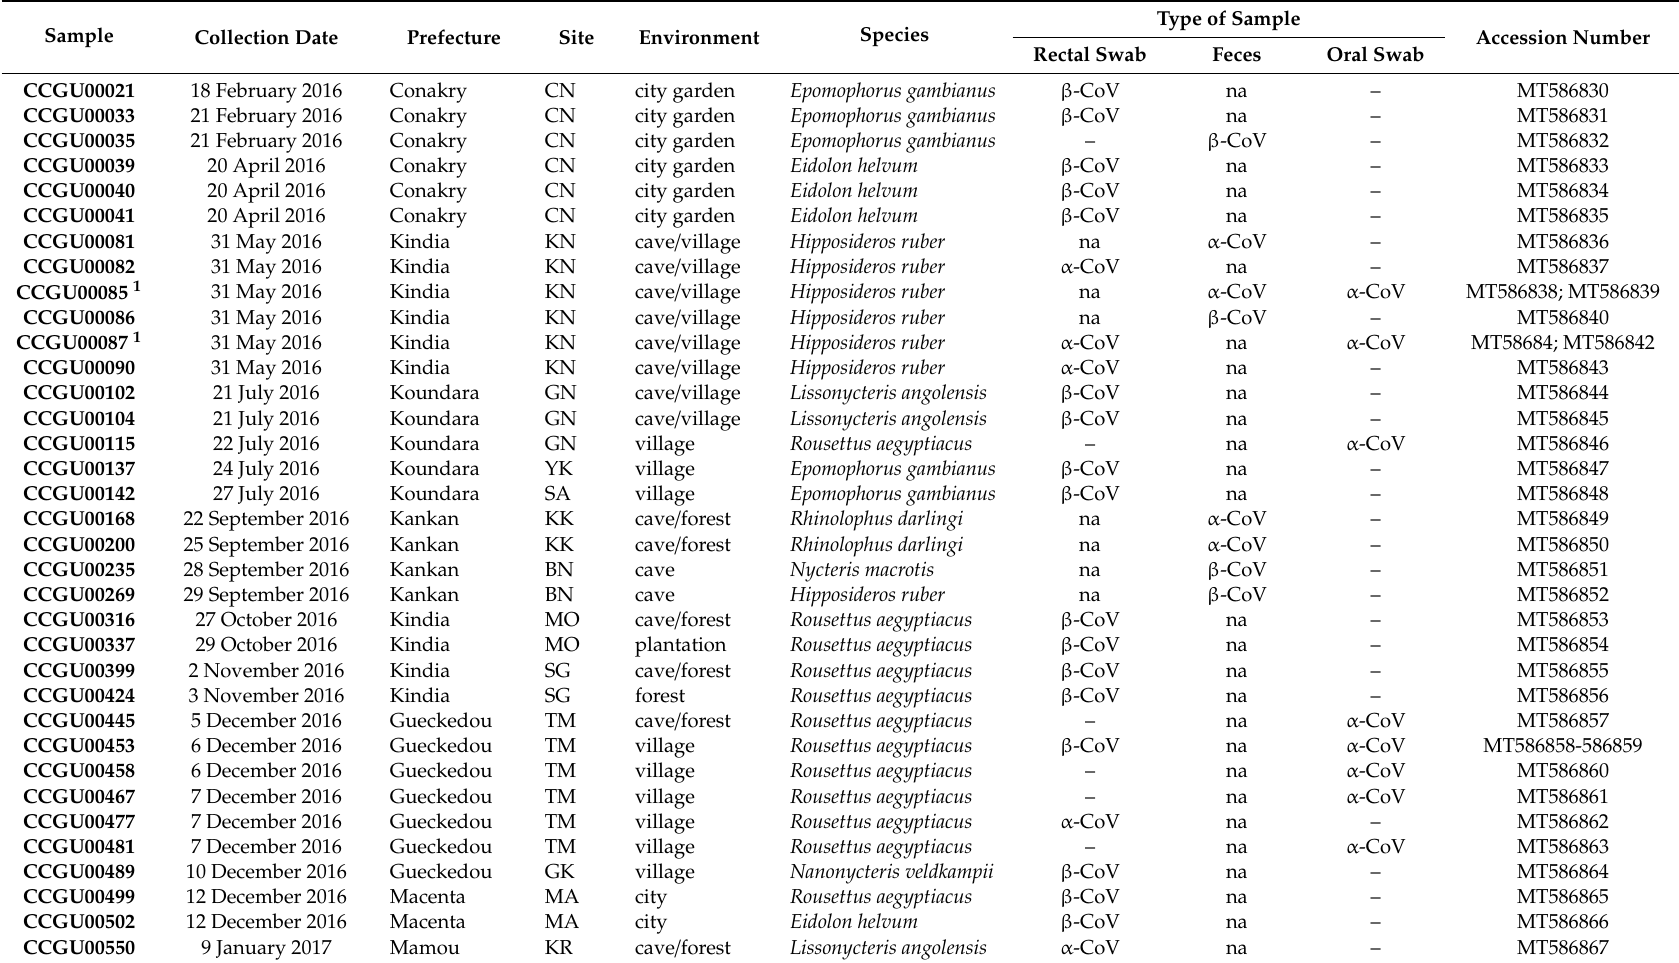
Table 3. Detail on bat samples in which coronavirus sequences have been amplified. Sites are abbreviated as in Table